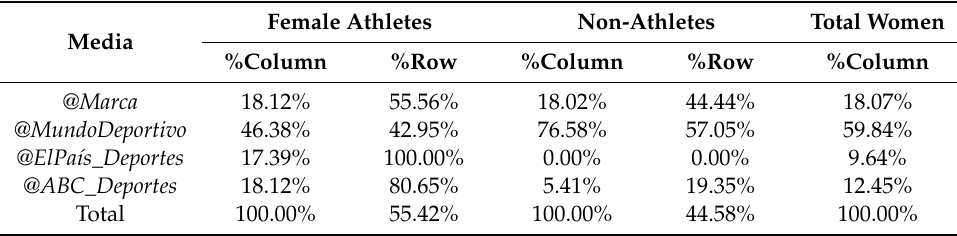
Table 6. Distribution of sample profiles of featured women (athletes or non-athletes) according to the communication media in the tweets (n = 249).